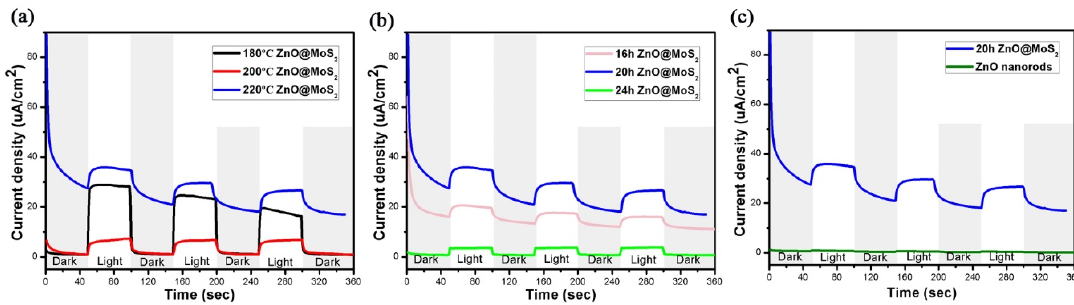
Figure 7. (a – c ) the i-t curve of the sample was prepared in a 0.1 M Na 2 SO 4 (pH = 6.8) electrolyte under the action of a constant potential of 0.3 V vs. SCE.